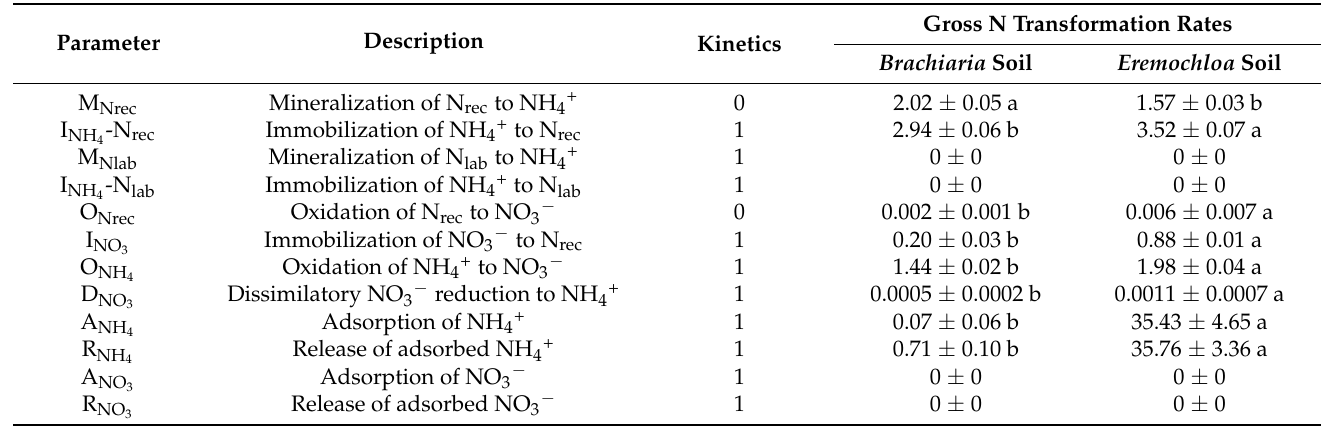
Table 2. Descriptions and average gross N transformation rates (mean ± standard